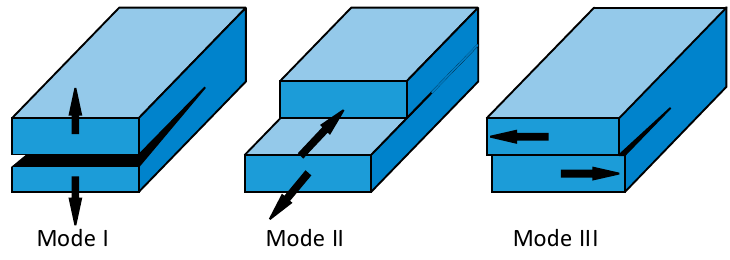
Figure 8. Modes of crack propagation.